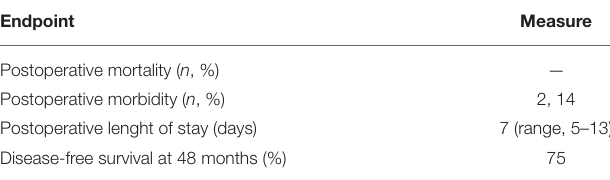
TABLE 2 | Main study’s